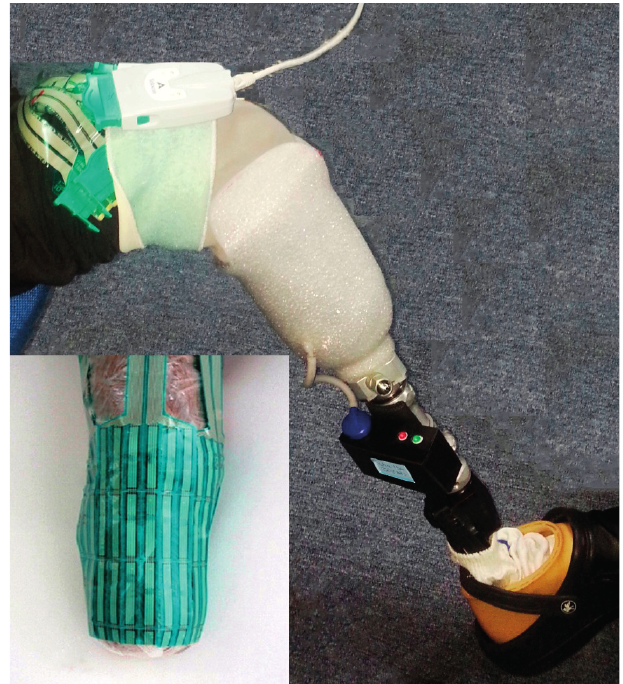
Figure 5. F-Scan test